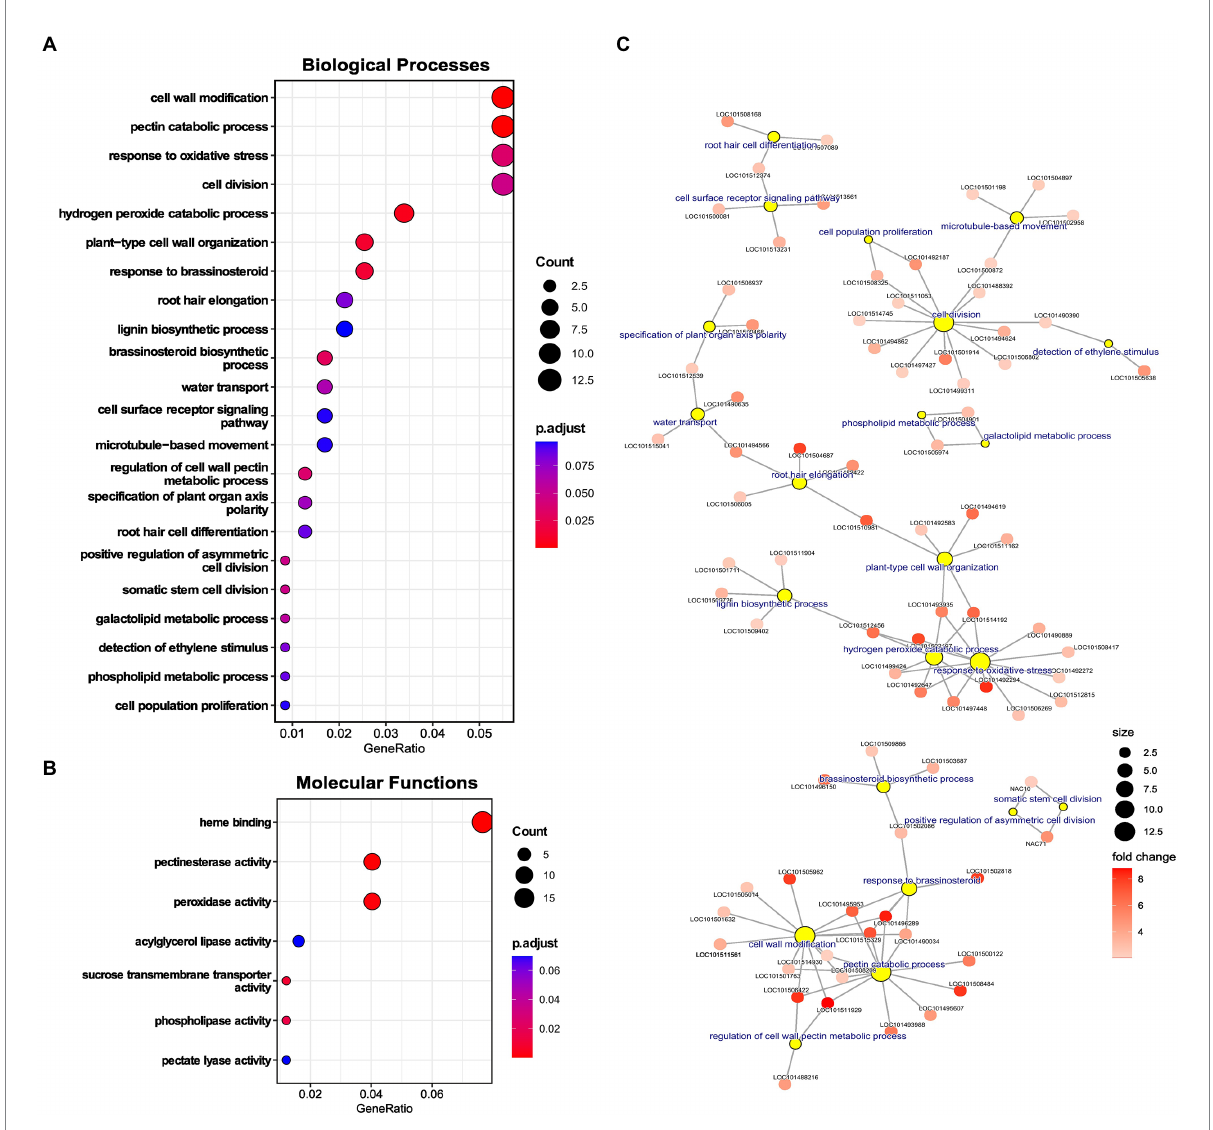
FIGURE 4 Enrichment analysis of upregulated genes in low phosphorus (LP) conditions in Root-RH. (A) Dot plot of enriched gene ontology (GO) terms for biological processes (BP) and (B) Molecular functions (MFs). The dot size represents the count of the genes under the term, and the color represents the adjusted value of p of enrichment. (C) Network of selected BP terms displaying genes under each term. The yellow circle represents the central nodes as BP term, and the sub-nodes are genes included in that term. The size of the yellow circle represents the gene count, and the color gradient of the sub-nodes (genes) depicts the fold change of the upregulated